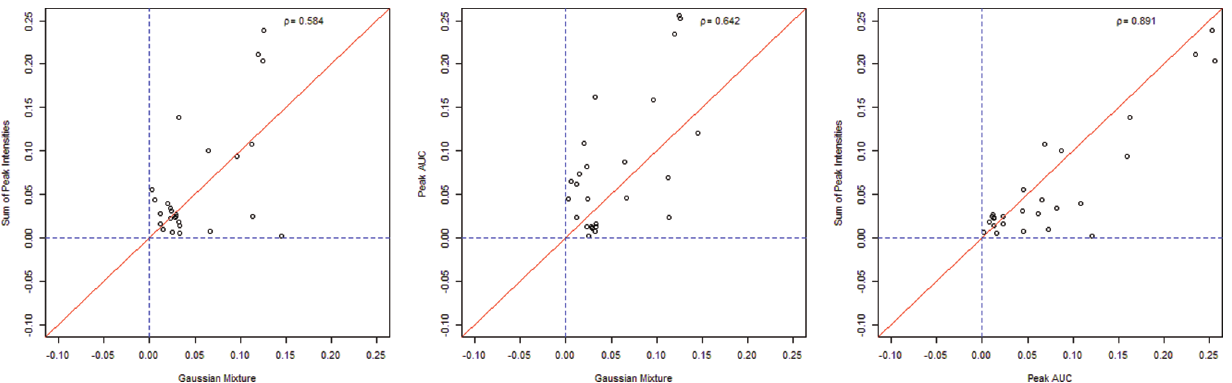
Figure 4. Correlation plots showing the difference in estimation error of the peak ratio for a given spectrum when different methods of peak ratio measurement. The red line denotes a correlation of r =1 and the blue lines denote 0% error in ratio estimation for that given method. Here we see that the Peak intensity and Riemann sum AUC methods of quantification correlate more highly with one another than with the Gaussian mixture method. Note that the GMM estimates tend to cluster closer to the blue line suggesting lower error.